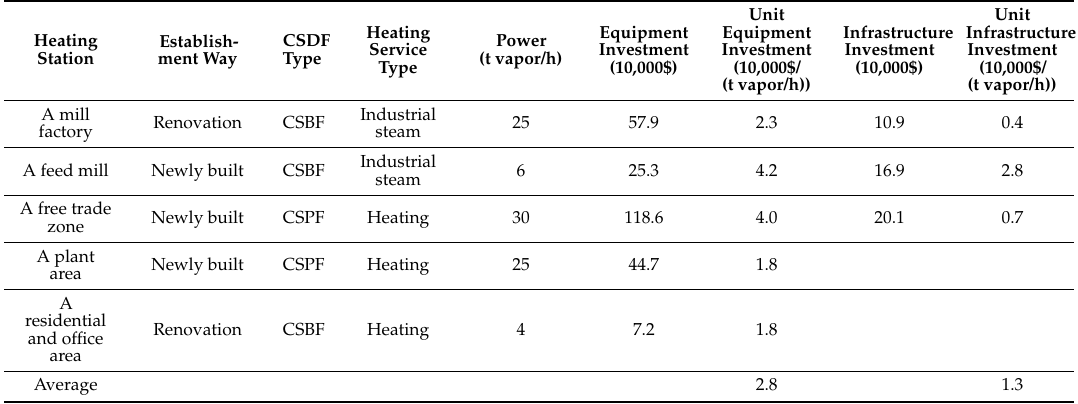
Table 4. Survey of the heating system and infrastructure investment in heating stations.